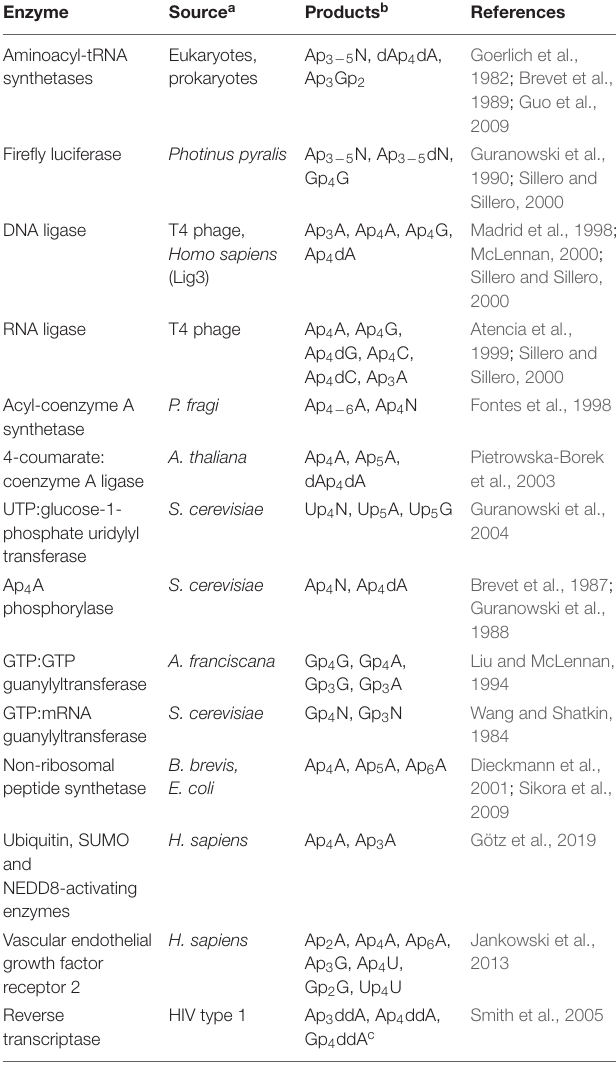
TABLE 1 | Enzymes synthesizing dinucleoside